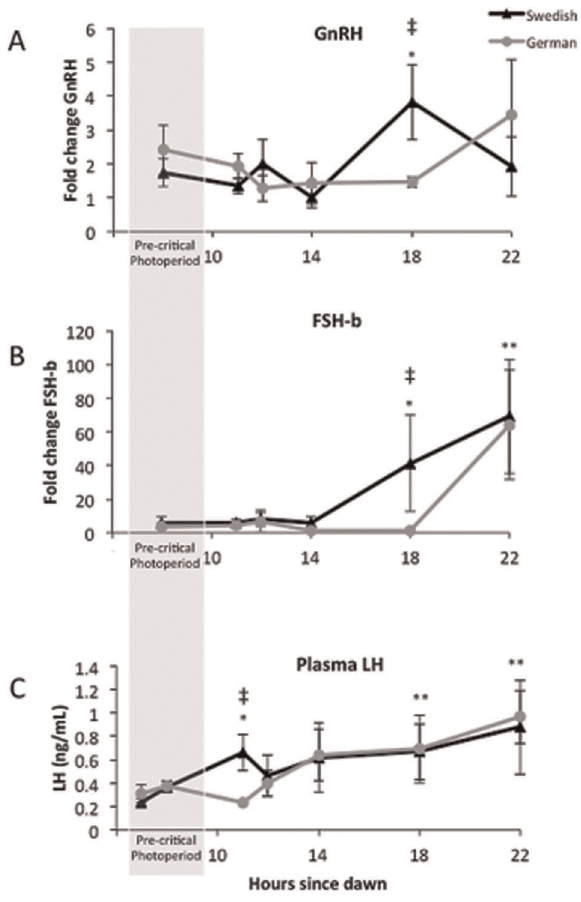
Figure 2. Fold change in mRNA expression of GnRH in the brain ( A ) and FSH ß ( B ) in the anterior pituitary gland relative to control genes during exposure to one long day in German and Swedish photosensitive great tit males. GnRH increases expres- sion 18 hours after dawn in the Swedish population only, while FSH ß stimulated in the Swedish population at 18 hours and both populations by 22 hours after dawn. Circulating LH concentration (C) during exposure to one long day in German and Swedish photosensitive great tit males. LH concentration increased at 11 hours after dawn in the Swedish population, and slowly increases in both populations by 18 hours after dawn. The symbols ** indicate both populations differ from pre-threshold values, and * indicates a single population differs from pre-threshold values, { indicates populations differ significantly from each